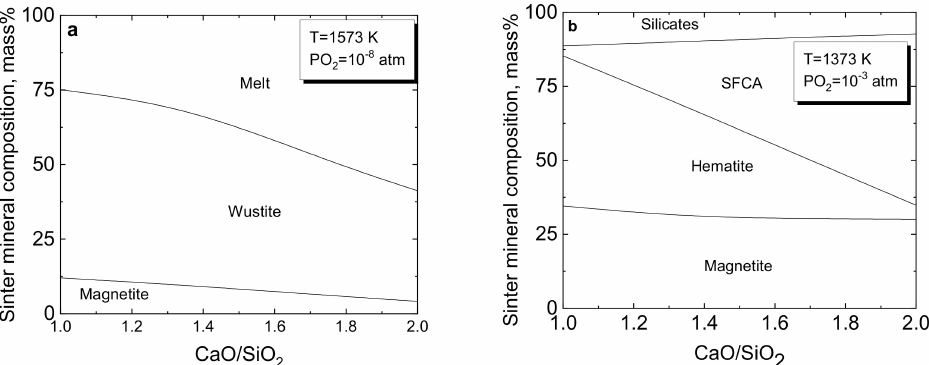
Figure 9. Mineral composition of sinter under varied basicity at temperature of ( a ) 1573 and ( b ) 1373 K.